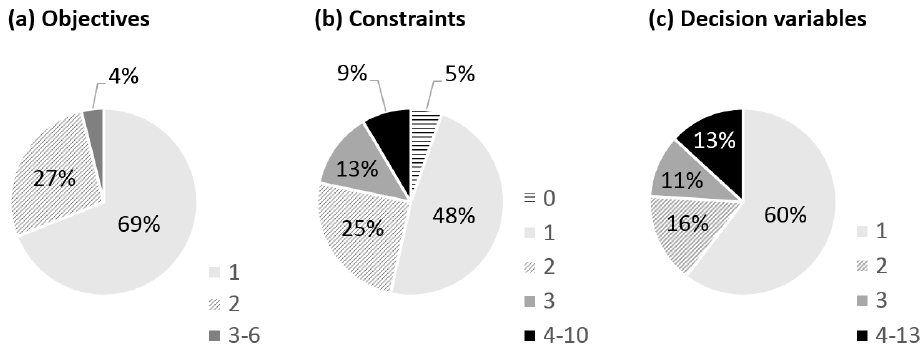
Figure 3. Optimisation models (of papers from Appendix A Table A1) by: ( a ) number of objectives, ( b ) number of constraints, ( c ) number of types of a decision variable, in an optimisation model.